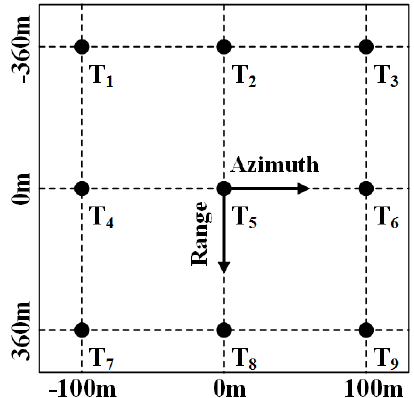
Figure 10. Distribution of point targets in simulation.